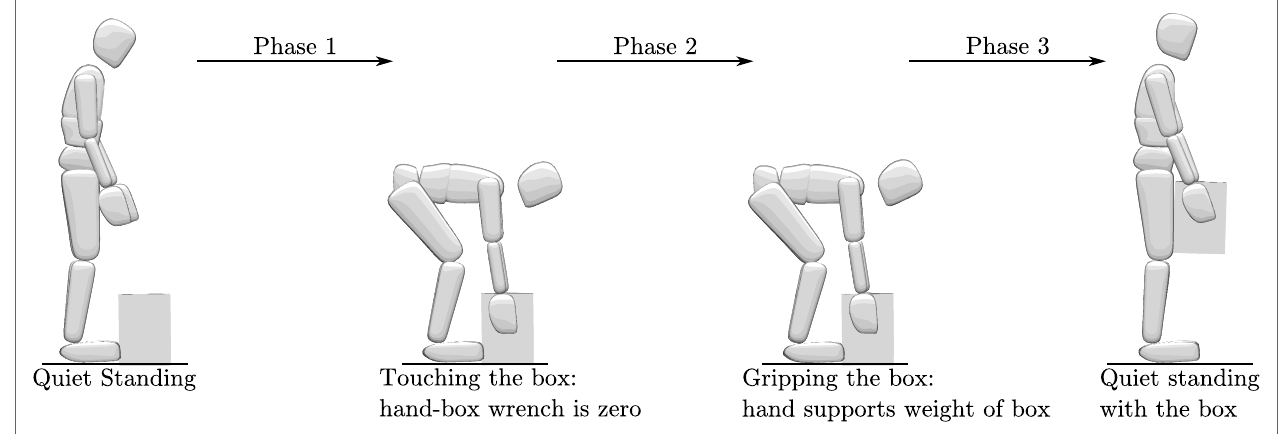
FIgURe 3 | The stooping box lift is formulated as a three-phase OCP: stand to touching the box, touching the box to gripping the box, and finally lifting the box to a standing position.